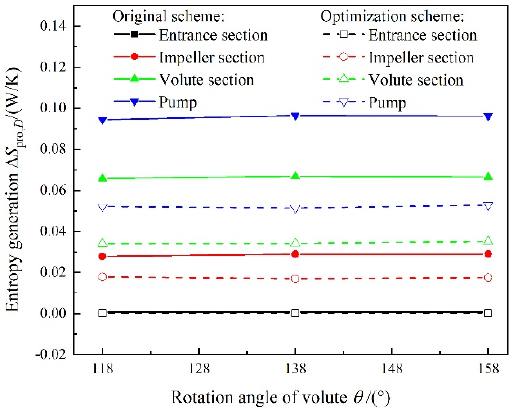
Figure 20. Distribution of entropy production and total entropy production of each flow passage component.